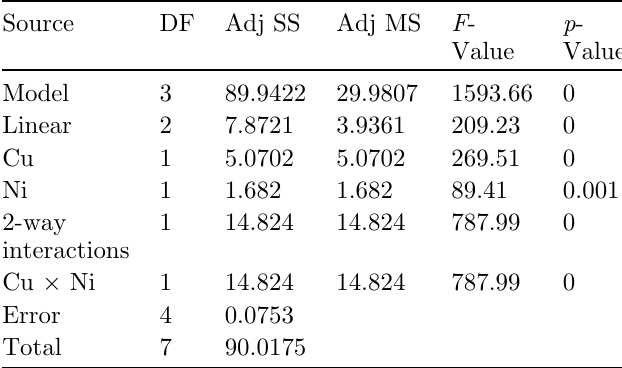
Table 8. Analysis of